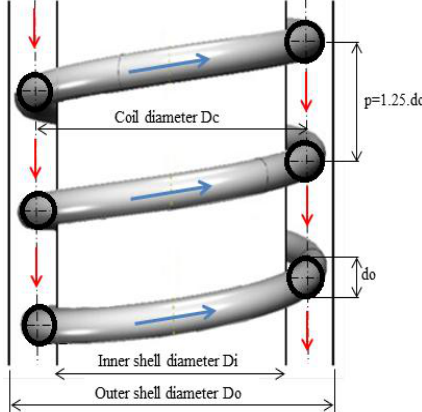
Figure 3. Schematic cut-away view of a helical coil heat exchanger.